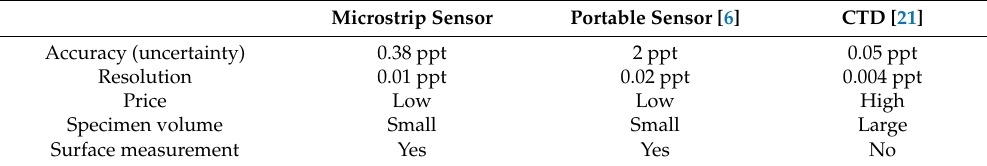
Table 2. Performance and characteristics of salinity sensors. CTD: conductivity-temperature-depth sensor.